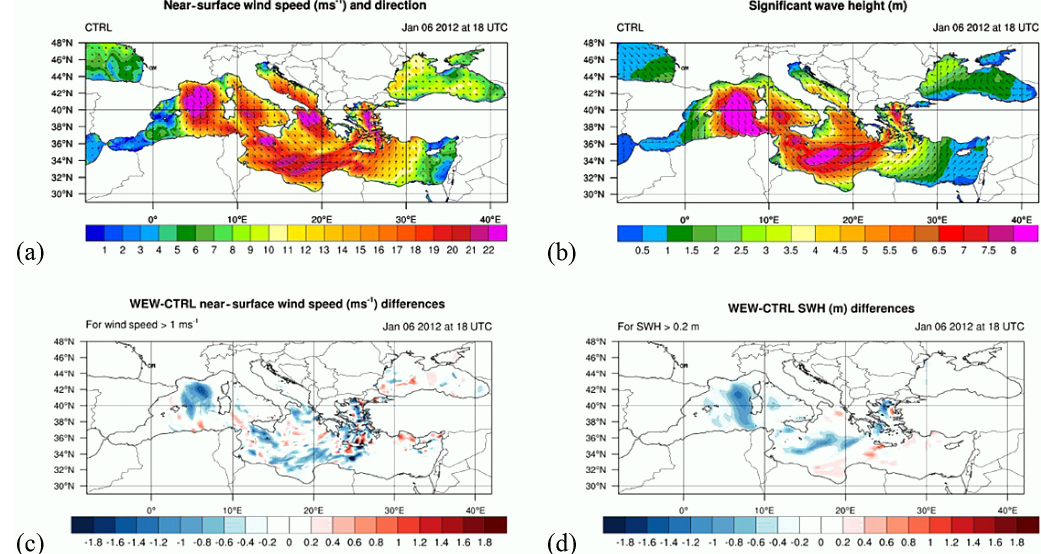
Figure 11. Panel of the horizontal distribution for the (a) wind speed, (b) SWH, and their differences between WEW and CTRL experiments for the (c) wind speed and (d) SWH for 6 January 2012 at 18:00UTC.